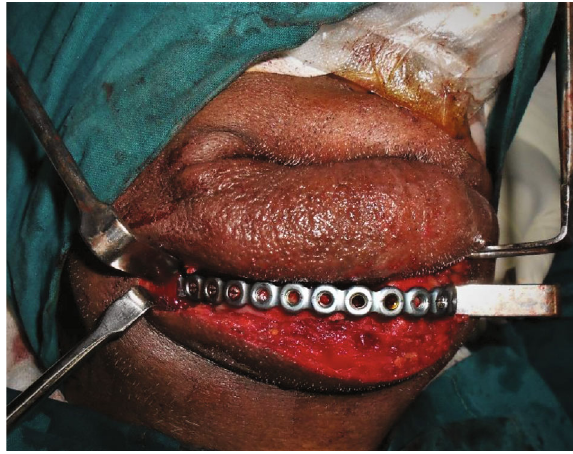
Figure 12: After the removal of the hardware and necrotic